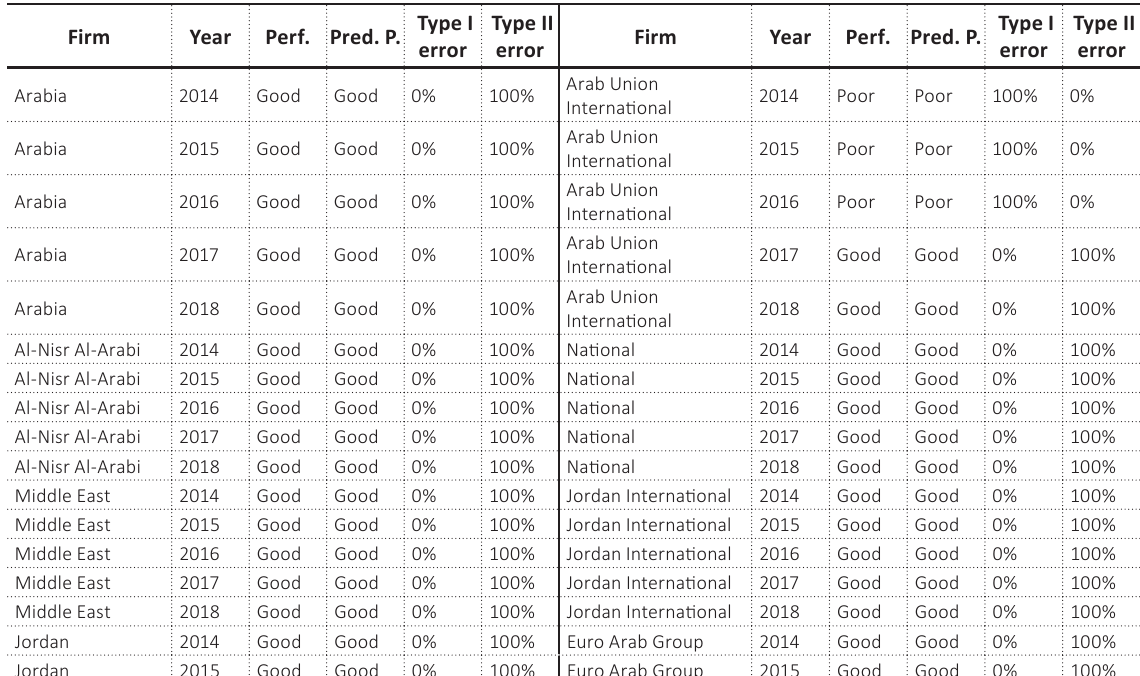
Table 7. Comparison of real performance vs. predicted